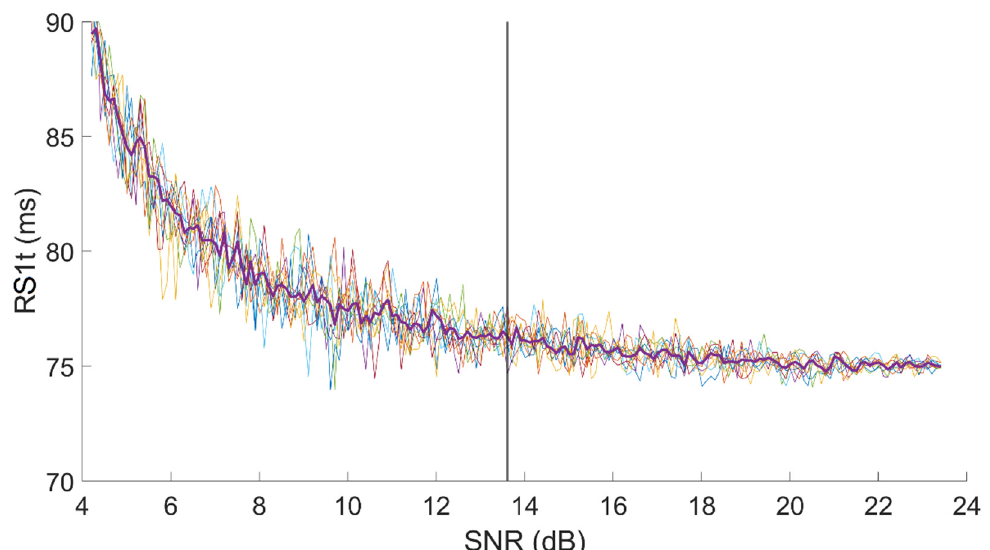
Figure 4. Example of R-S 1,T variation in function of the SNR of the signal. Each colored line represents a different test on the same signal. The thicker violet line represents the median, which is taken as representative for the signal. The vertical line represents the minimum SNR value considered as acceptable.